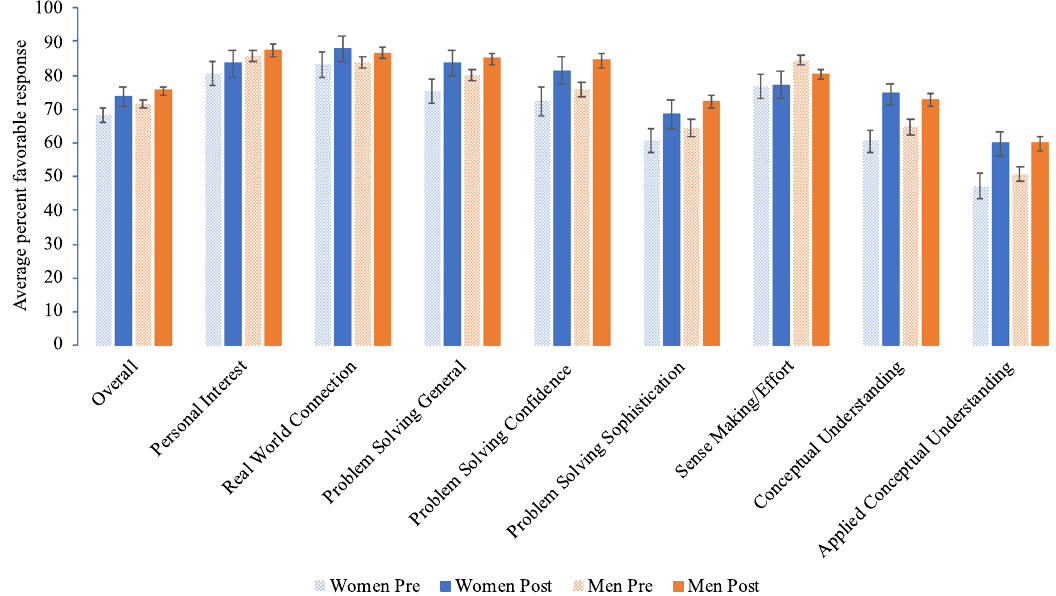
FIG. 2. CLASS pre- and postpercent favorable scores for men and women broken down by category. Error bars represent the standard error of the